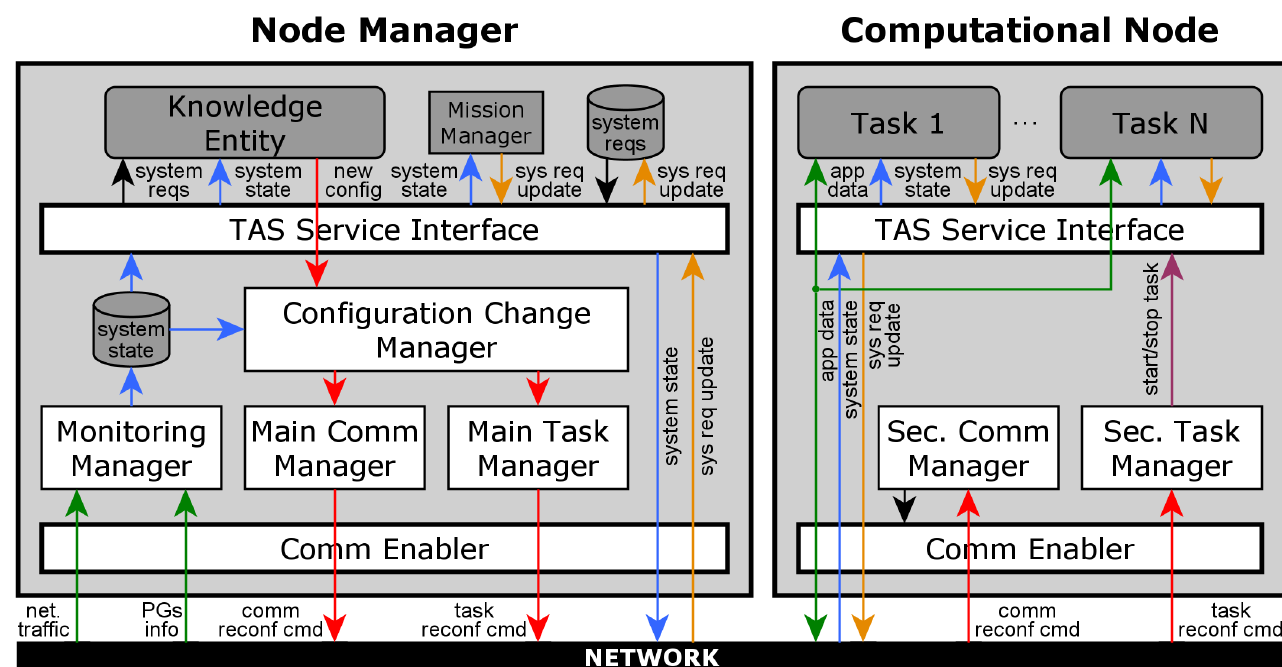
Figure 7. Internals of the Node Manager and a Computational